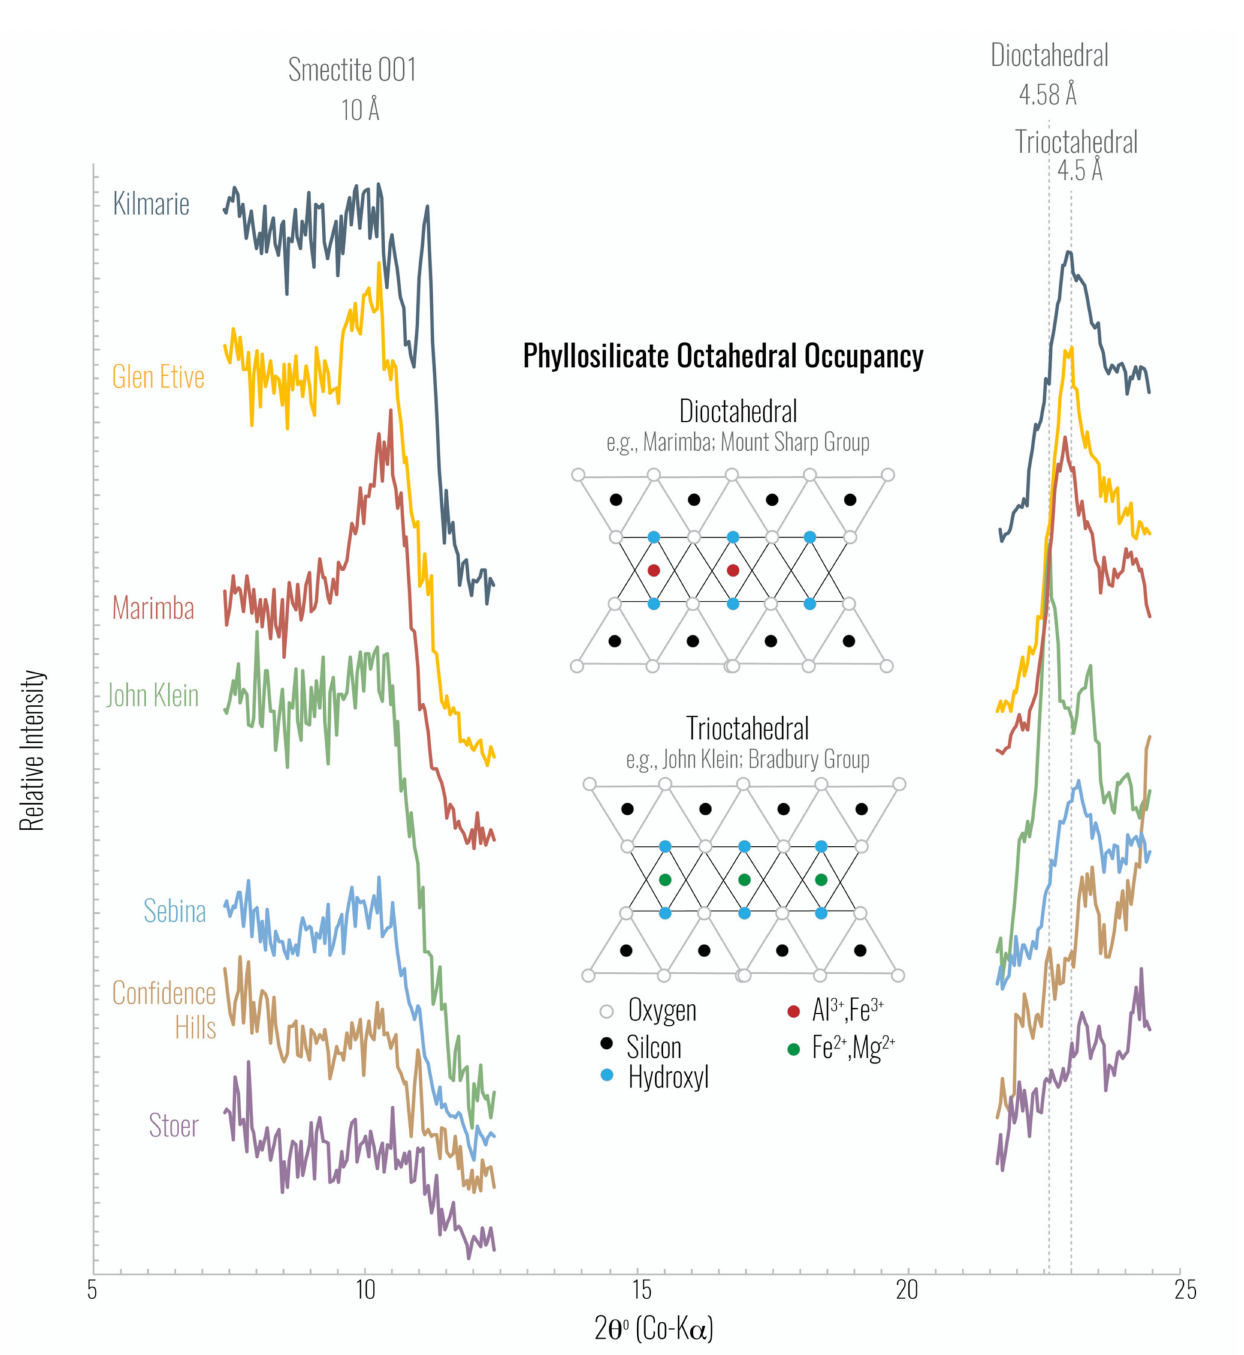
Figure 5. X-ray diffraction patterns for select mudstone drills throughout Curiosity’s traverse. The 2 θ range is restricted to highlight the key phyllosilicate reflections that the CheMin team uses to identify discrete clay mineral phases. Additionally, the crystal structure of smectite is illustrated to demonstrate how the octahedral site occupancy has changed throughout the